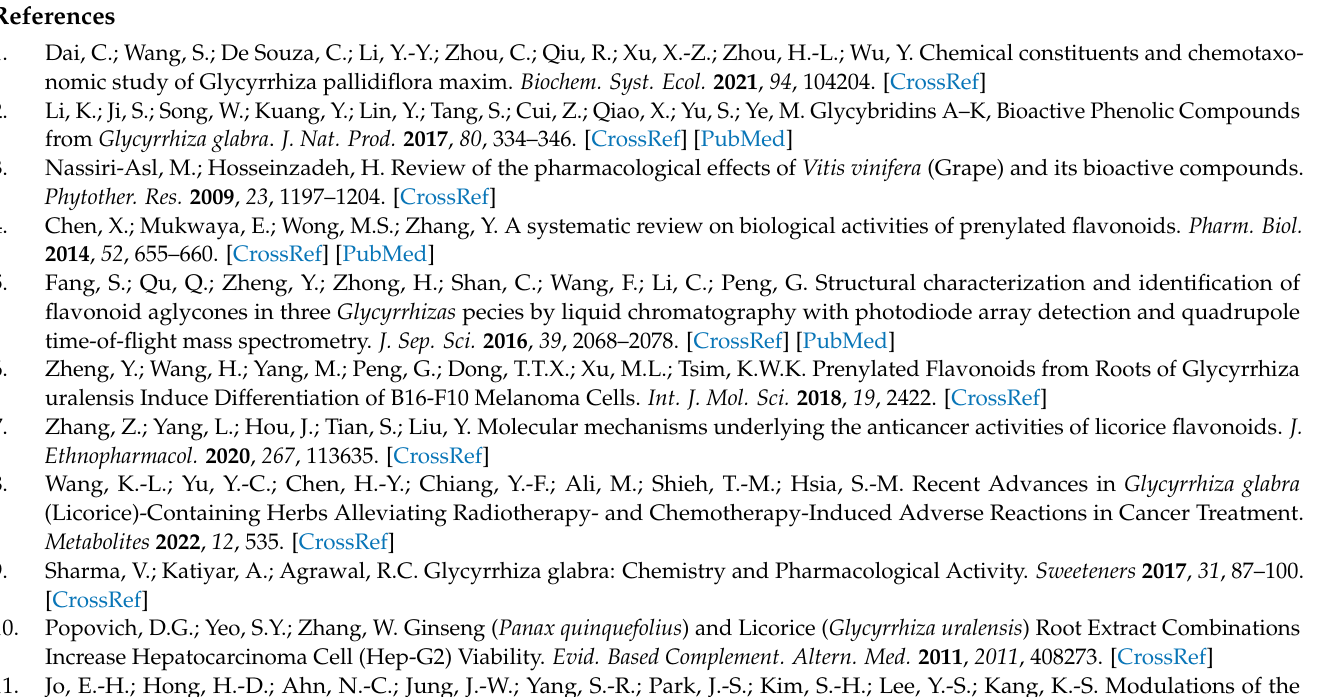
Figure S7: HSQC spectrum of compound 1 in DMSO- d 6 , Figure S8: HMBC spectrum of compound 1 in DMSO - d 6 , Figure S9: 1 H- 1 H COSY spectrum of compound 1 in DMSO-d6, Figure S10: UV spectrum of compound 2 , Figure S11: HR-ESI-MS spectrum of compound 2 , Figure S12: 1 H NMR spectrum of compound 2 in DMSO- d 6 (400 MHz), Figure S13: 13 C NMR spectrum of compound 2 in DMSO- d 6 (100 MHz), Figure S14: DEPT 135 spectrum of compound 2 in DMSO- d 6 , Figure S15: HSQC spectrum of compound 2 in DMSO- d 6 , Figure S16: HMBC spectrum of compound 2 in DMSO- d 6 , Figure S17: 1 H- 1 H COSY spectrum of compound 2 in DMSO- d 6 , Figure S18: UV spectrum of compound 3 , Figure S19: HR-ESI-MS spectrum of compound 3 , Figure S20: 1 H NMR spectrum of compound 3 in DMSO- d 6 (400 MHz), Figure S21: 13 C NMR spectrum of compound 3 in DMSO- d 6 (100 MHz), Figure S22: DEPT 135 spectrum of compound 3 in DMSO- d 6 , Figure S23: HSQC spectrum of compound 3 in DMSO- d 6 , Figure S24: HMBC spectrum of compound 3 in DMSO- d 6 , Figure S25: 1 H- 1 H COSY spectrum of compound 3 in DMSO- d 6 , Table S1: Table of Rf value and UV lambda Max of isolated compounds, in the Supplementary